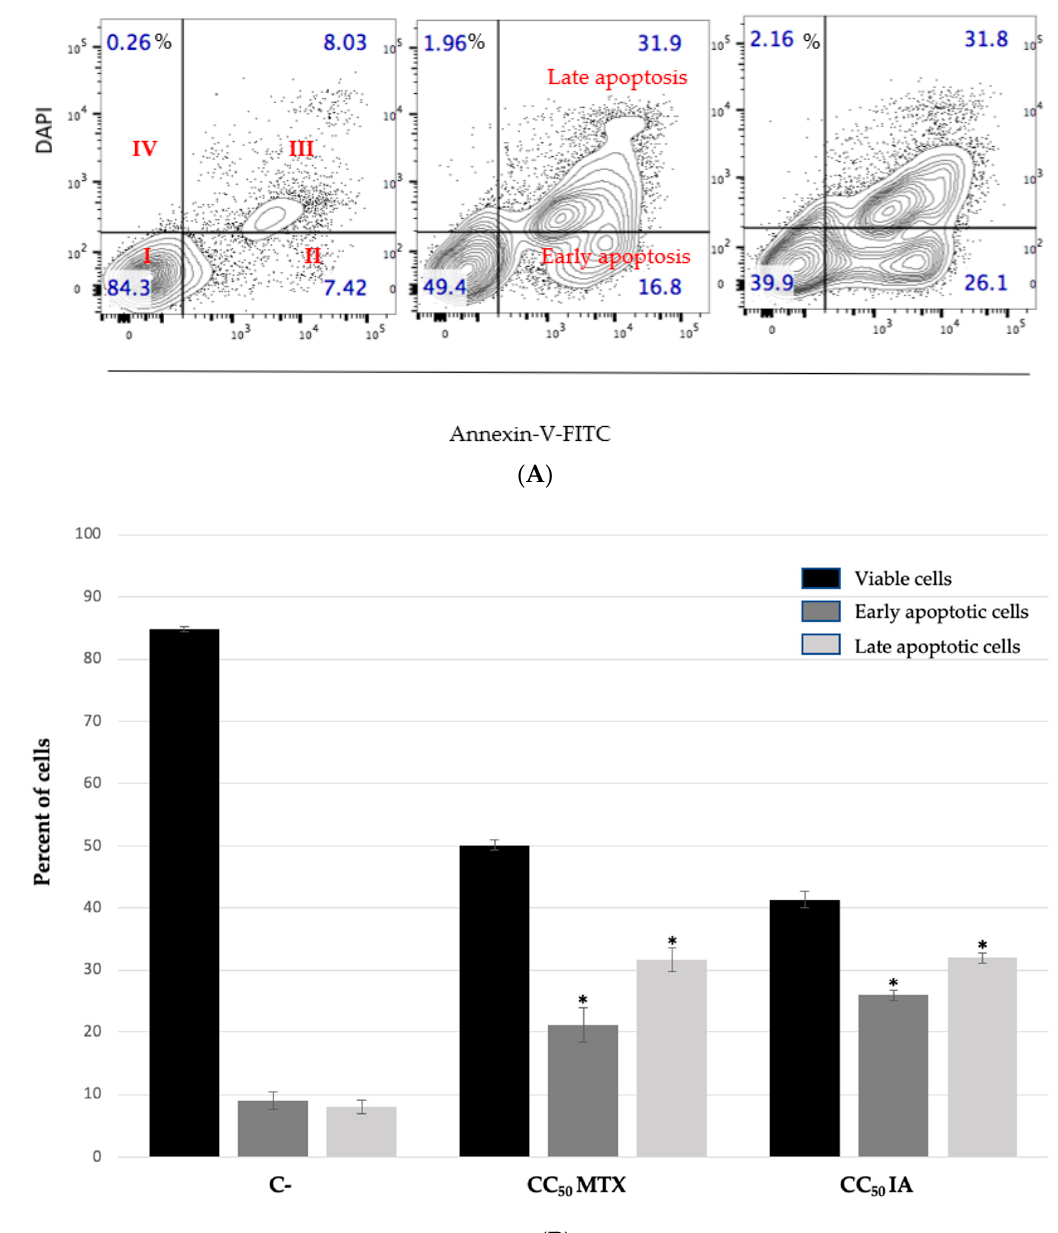
Figure 2. Apoptosis induced on U-937 cells by incomptine A ( IA ) and methotrexate (MTX). U-937 cells were treated with CC 50 (mM) of compounds for 24 h. ( A ) Representative images of contour maps from evaluated treatments with relative death percentage for each quadrant (red numbers). Quadrant I annexin V-/DAPI-; quadrant II annexin V+/DAPI- early apoptosis; quadrant III annexin V+/DAPI+ late apoptosis, and quadrant IV annexin V-/DAPI-. Apoptotic population increases in IA and MTX CC 50 treatments, revealing apoptosis induction. ( B ) Histograms of apoptosis were calculated respectively to negative control, finding significant differences in incomptine A and MTX treatments. Data is expressed as means ± SEM, n = 3; * p < 0.05.